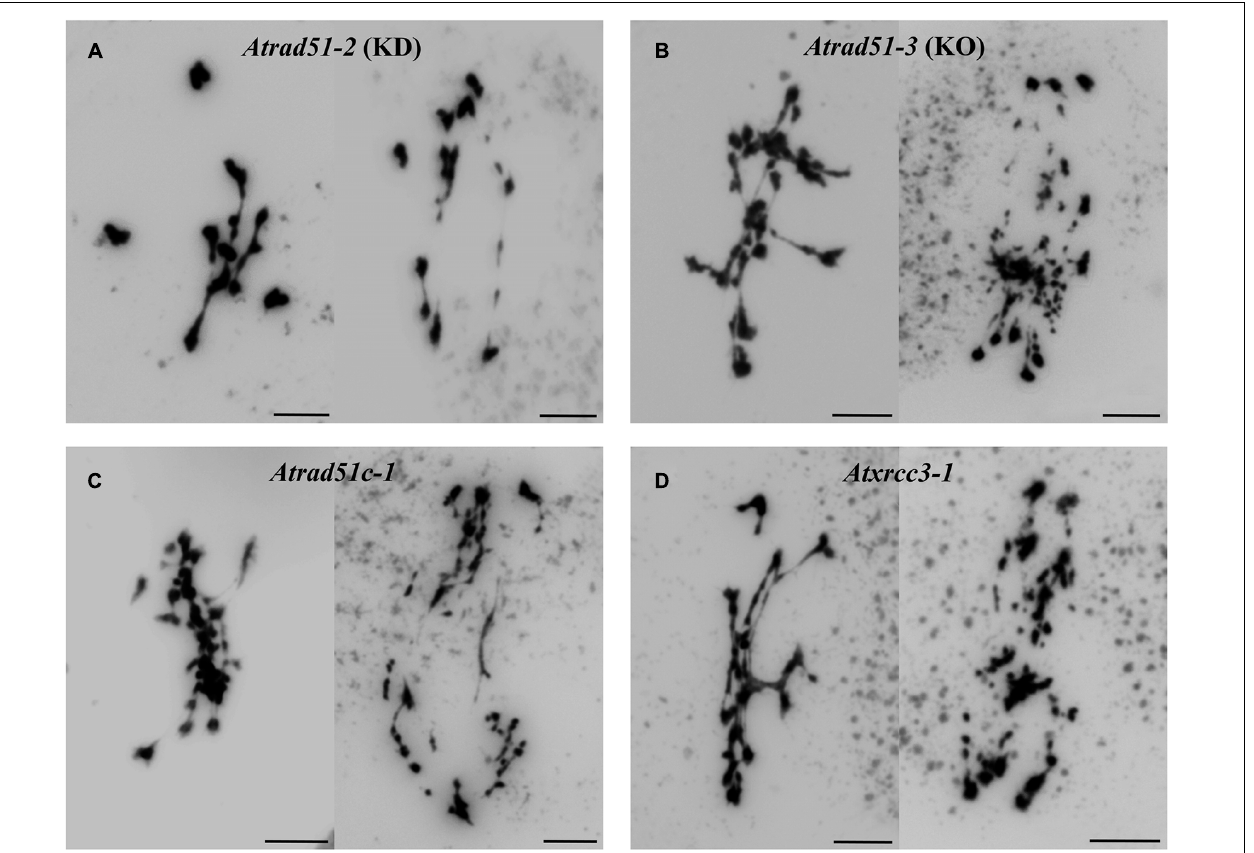
FIGURE 3 | Some examples of metaphases I and anaphases I in two Atrad51 mutants and defective mutants for the CX3 complex. (A) Knockdown (KD) mutant for Atrad51 : Atrad51-2 . (B) Knockout (KO) mutant for Atrad51 : Atrad51-3 (see Pradillo etal., 2012). (C) Atrad51c-1 . (D) Atxrcc3-1 . The meiotic phenotype of Atrad51-3 , Atrad51c-1 and Atxrcc3-1 is quite similar: an entangled mass of chromosomes involving